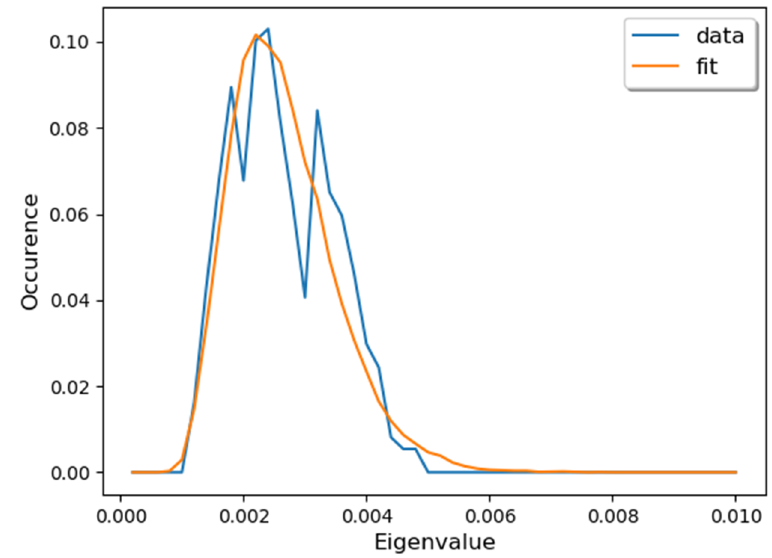
Figure 14. Statistical ‐ model ‐ fitting ‐ generalised gamma distribution over clean pixels from Bajina Basta clean mask.